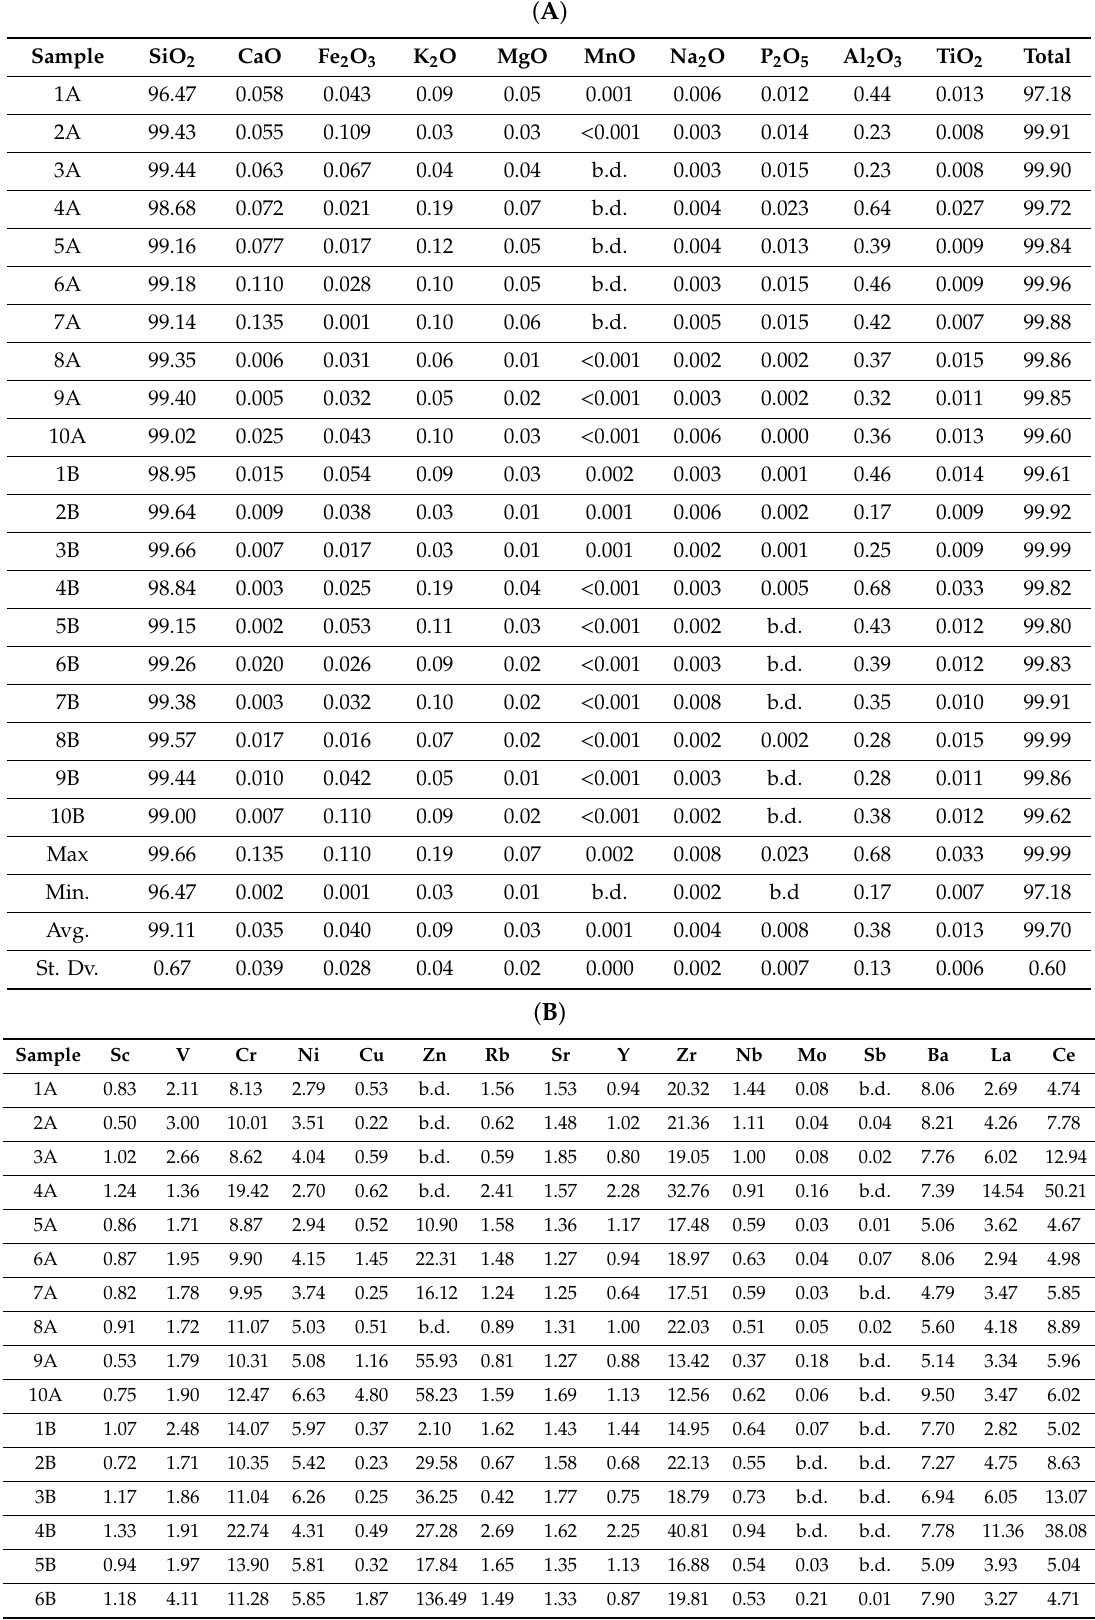
Table 1. Bulk rock geochemical data for sampled Kinnikinic Quartzite. ( A